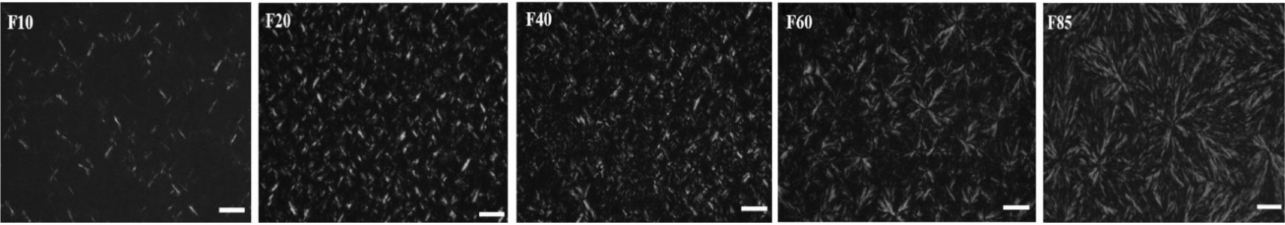
Figure 1. Polarized light micrographs of blended milk fats; scale bar 20 µ